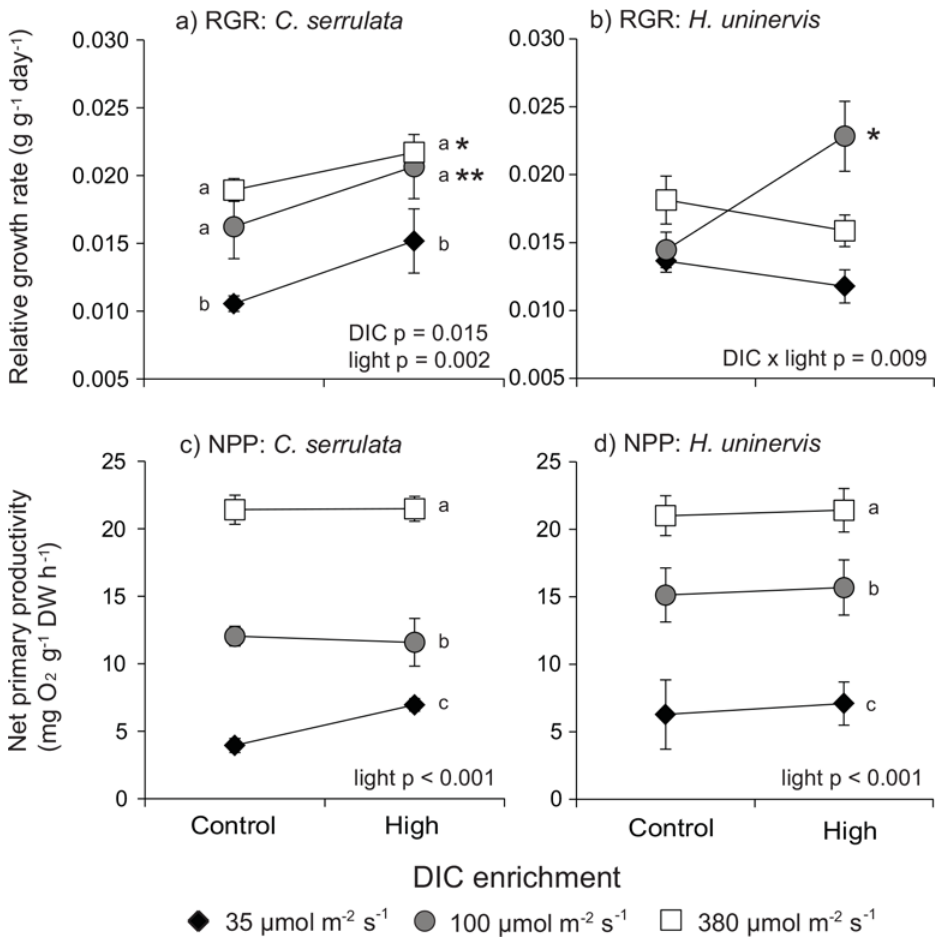
Fig 1. Comparison of relative growth rates and net primary productivity of C . serrulata and H . uninervis after two weeks exposure to light and DIC. (a-b) RGR- relative growth rate, (c-d) NPP – net primary productivity. Letters indicate significant differences between light treatments based on Tukey ’ s HSD test; asterisks indicate significant differences between DIC treatments based on ANOVA results where there is no interaction between light and DIC, or based on Tukey ’ s HSD test if an interaction was detected ( * p < 0.05; ** p < 0.01). Control DIC = 2063 μ M; high DIC = 2215 μ M. Means ( ± S.E.) are given (n = 3).